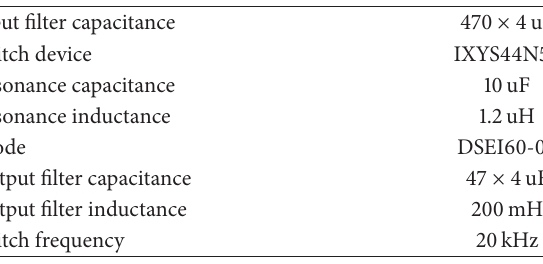
Figure11:TheinputpowerofBuckconverterversusgeneratorspeed at 8 m/s. Table 5: Buck converter parameter.